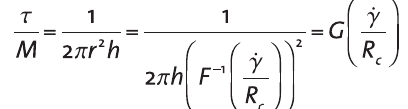
Figure 5 (left): Evolution of the yield stress extrapolated from a Her- schel-Bulkley model in rela- tionship with its shearing time for a pasty sludge (7.6% DM). Figure 6: Tangential velocity profiles as determined by MRI in a Couette geometry for two rotation velocities imposed, in a representation (V/R ; c R/R ) where R is the critical c c radius separating the sheared and unsheared zones. The insert shows the velocity profile for the low- est rotation velocity imposed at the approach of the unsheared region (from Tabuteau et al.